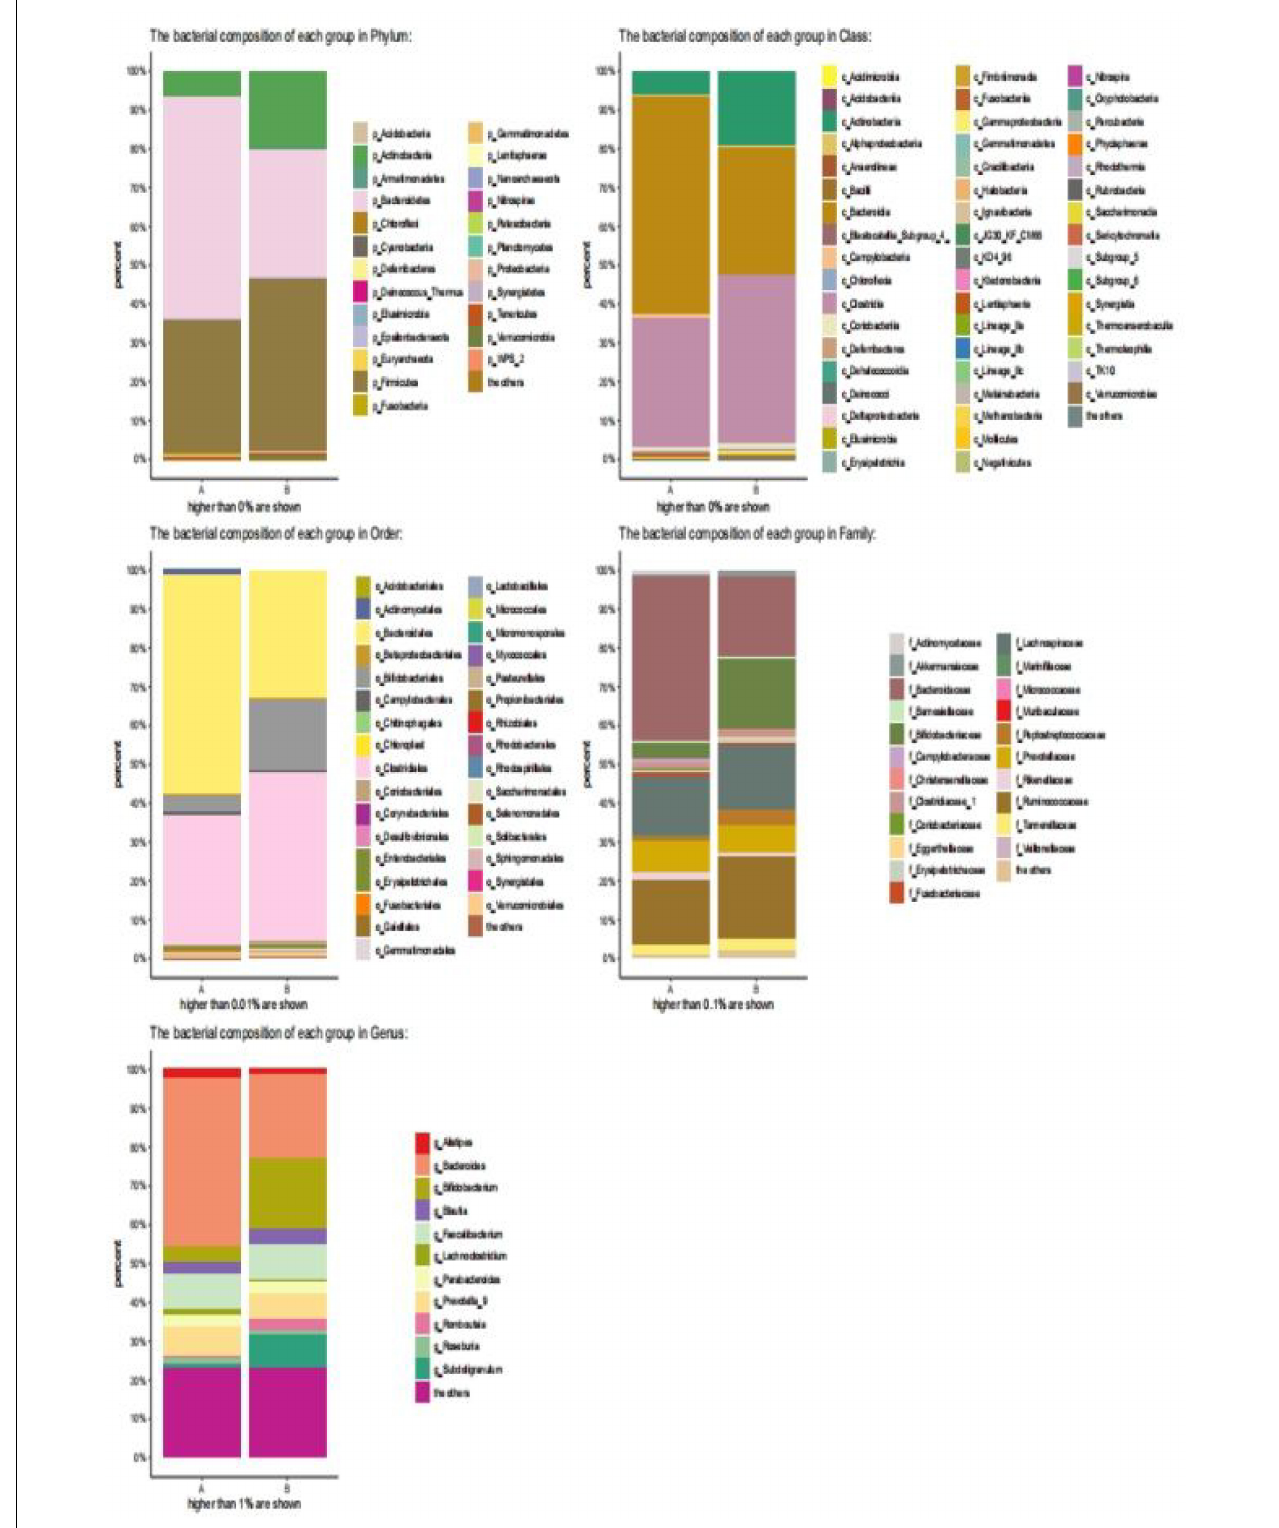
FIGURE 3 | Bar diagram of community. (The abscissa is the grouping of sample attribution, the ordinate is the proportion of species in the grouping, the column of different colors represents different species, and the length of the column represents the proportion of the species).